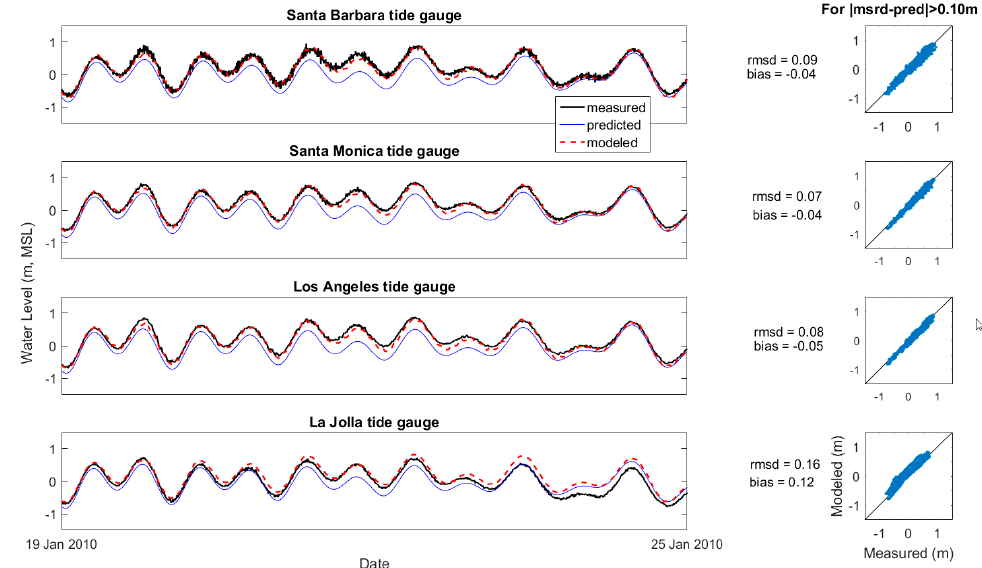
Figure 9. Comparison of modeled and measured water levels at the Santa Barbara, Santa Monica, Los Angeles, and La Jolla tide gauges during the January 2010